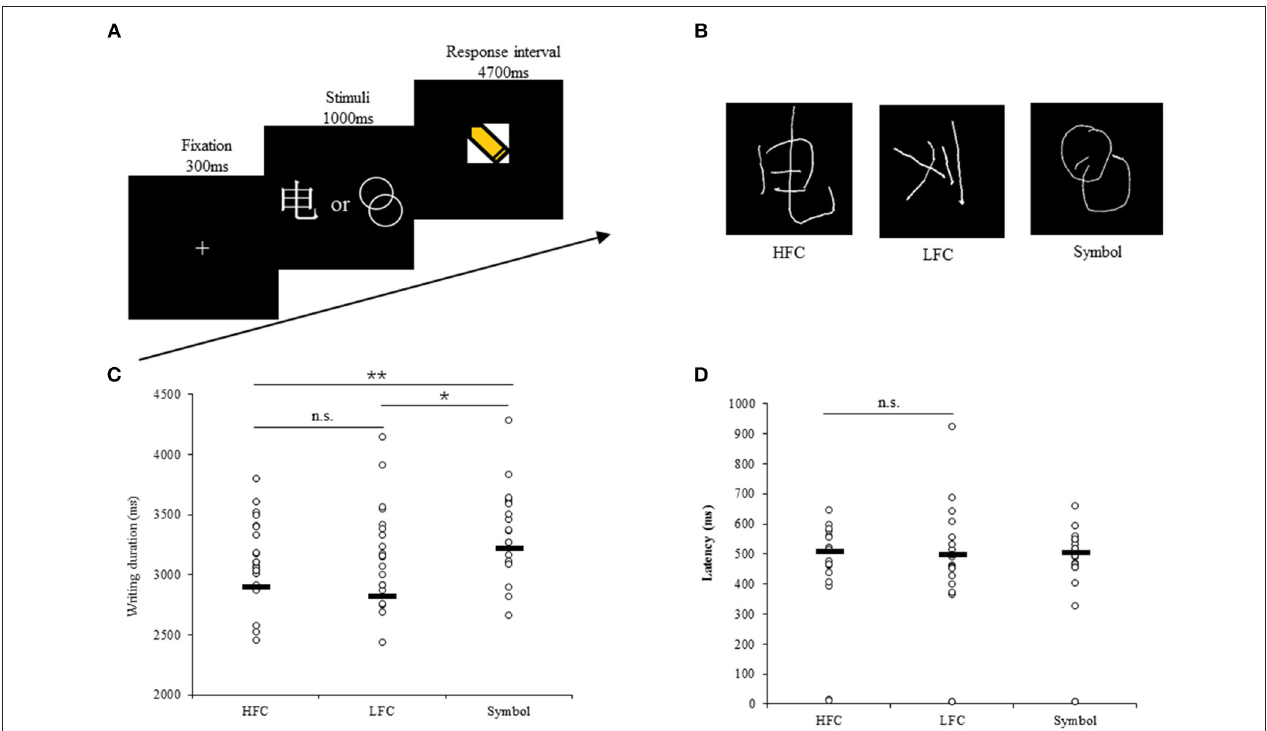
FIGURE 1 | Experimental design and behavioral recordings during fMRI scanning. (A) Temporal structure of each task trial. (B) Examples of behavioral response of writing characters and drawing geometric symbols. Scatter plots of writing duration (C) and latency (D) in each task. The black lines show the group median. n.s., not significant. * p < 0.05, ** p <